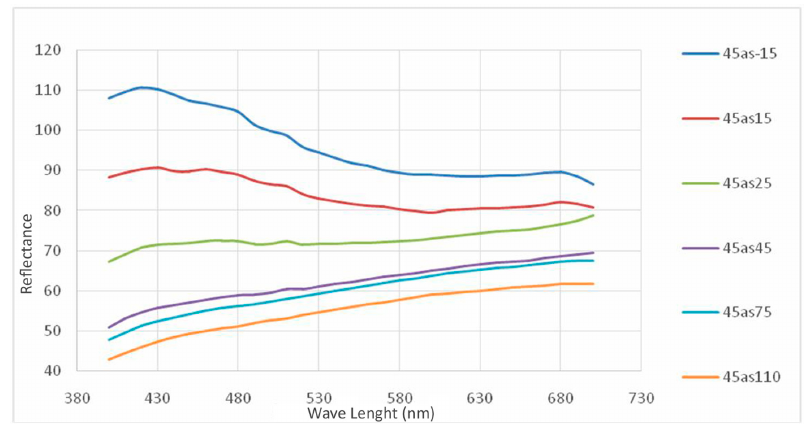
Figure 20. The sample’s spectral reflectance curves for the six measurement geometries. The geometries closest to the direction of brightness are more luminous and bluish.